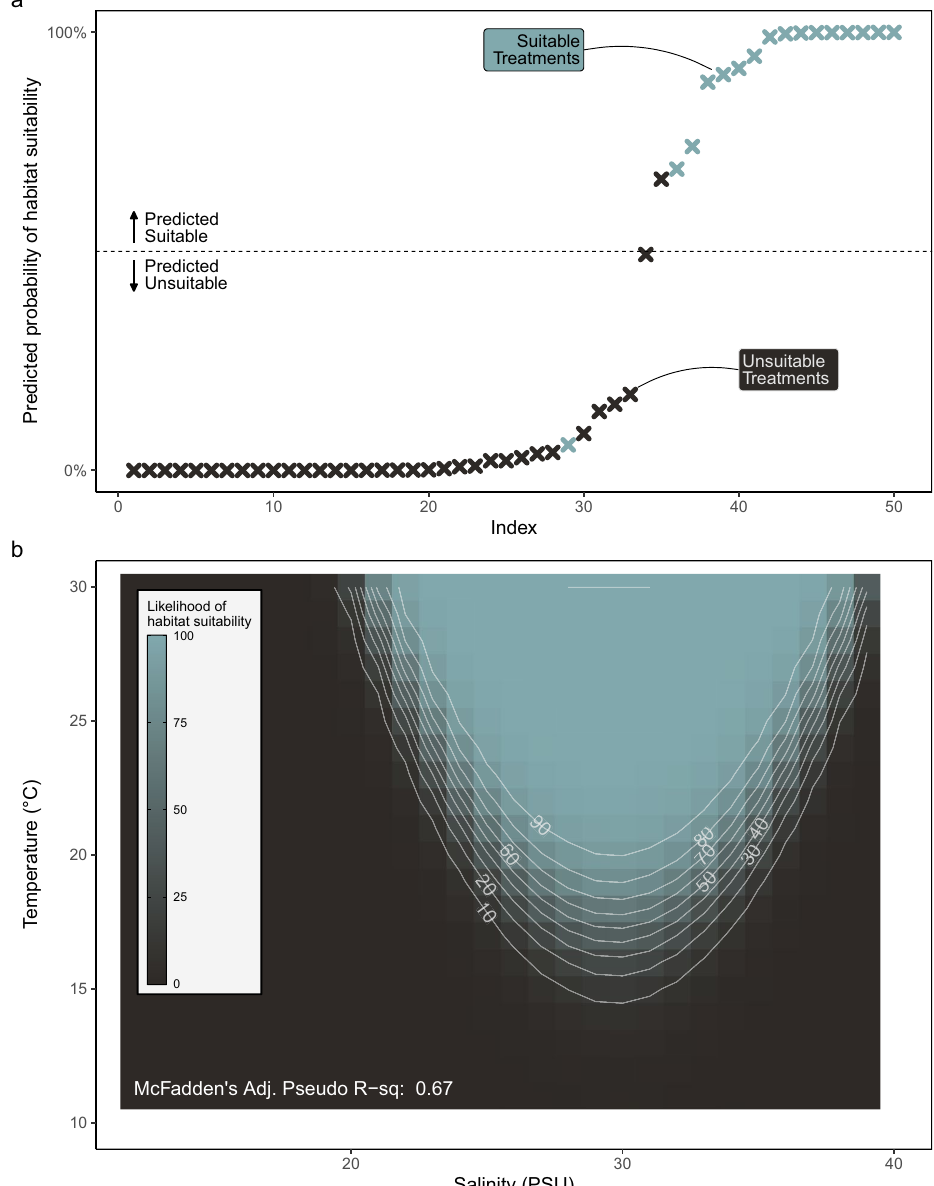
Figure 6. Habitat suitability likelihood of experimental treatments for Olympia oyster larvae. ( a ) Predicted habitat suitability in 50 environmental treatments. Treatments above the horizontal line are predicted as survivable. Color represents observed habitat suitability in experimental treatments. ( b ) GLM-predicted likelihood of suitability across salinity (9–39PSU) and temperature (11–30 °C). Color represents percent likelihood of 25% or more larvae growing to